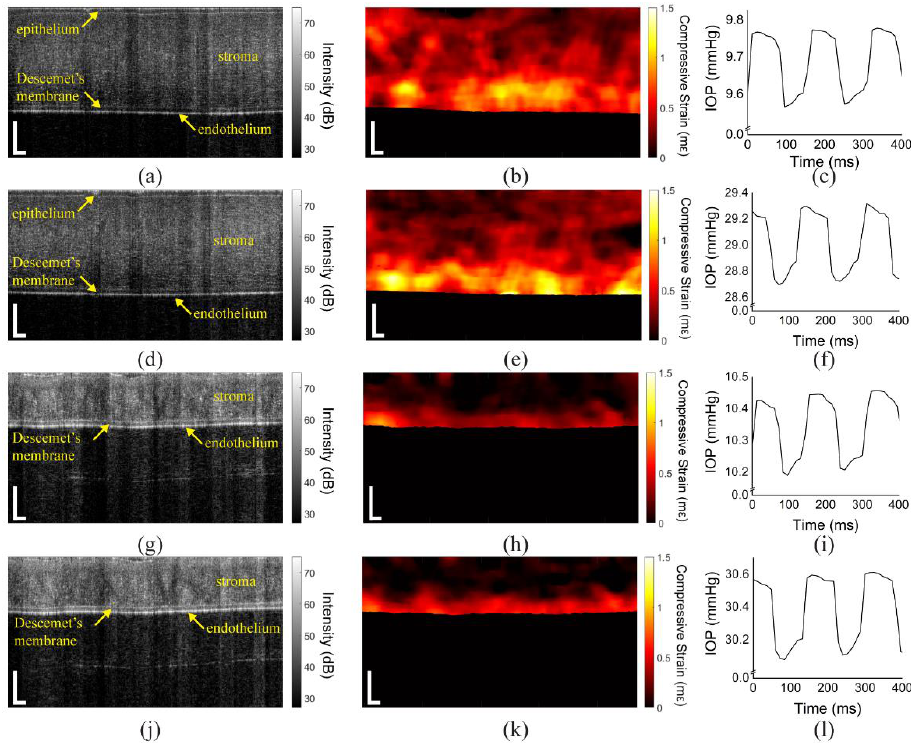
Figure 2. (left column) OCT images, (middle column) strain maps, and intraocular pressure (IOP) of typical in situ rabbit corneas. ( a – c ) A typical untreated sample at a baseline of ~10 mmHg and the same sample at ( d – f ) a baseline of ~29 mmHg. ( g – i ) The same sample after corneal collagen crosslinking (CXL) at a baseline of ~10 mmHg and at ( j – l ) a baseline of ~30 mmHg. Scale bars are 250 µm. 250 µ